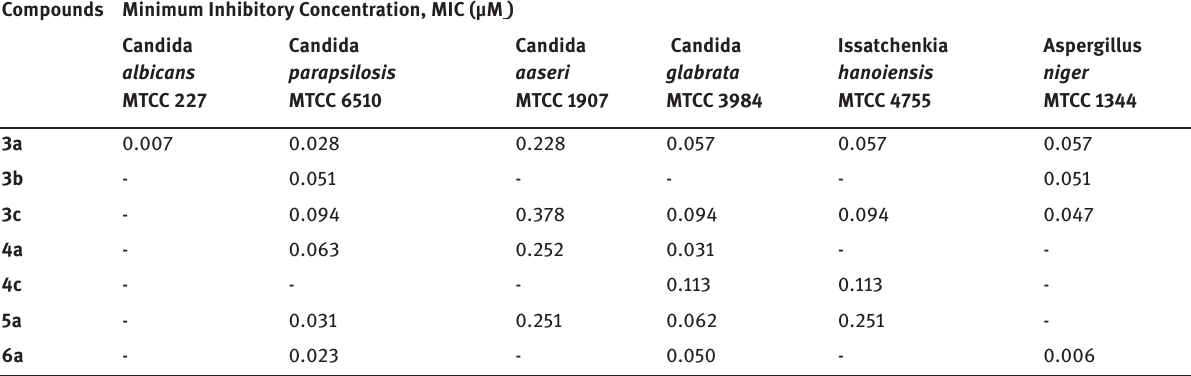
Table 2: Antifungal activity of compounds by broth dilution method. Compounds Minimum Inhibitory Concentration, MIC (μM )